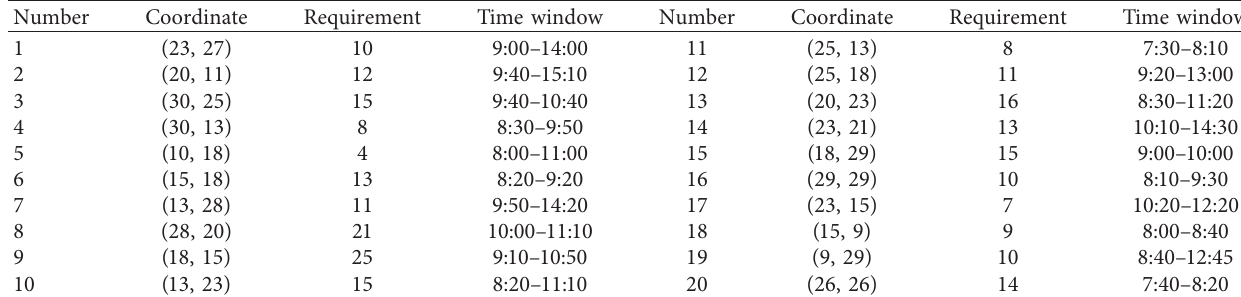
Table 2: Table of customer order information.